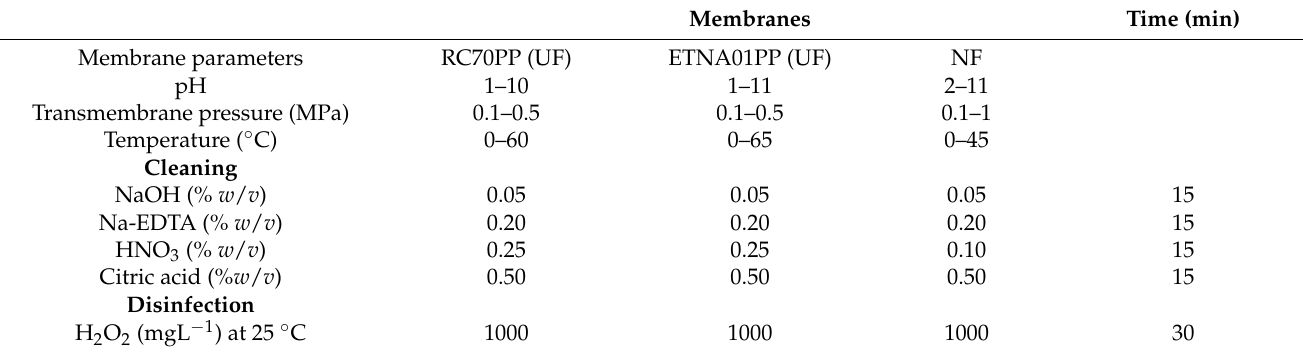
Table 1. Process of cleaning and disinfection of membranes a